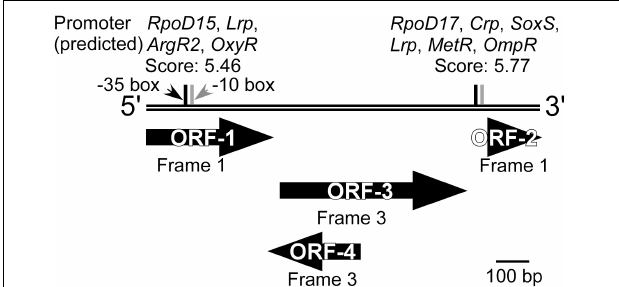
FIGURE 4 | Overview of the DNA inserted into the clone isolated from the KY11-E06_0–5 library after induction with 3-chlorobenzoate under anaerobic conditions. ORFs identified by ORFfinder and BLASTX, and potential promoters predicted using FGENESB and with threshold values > 3.00 are